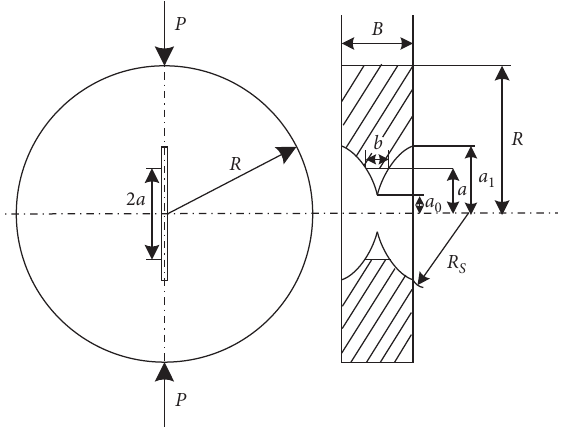
Figure 1: Sample geometry parameters of the CCNBD specimen (ISRM, 1995)